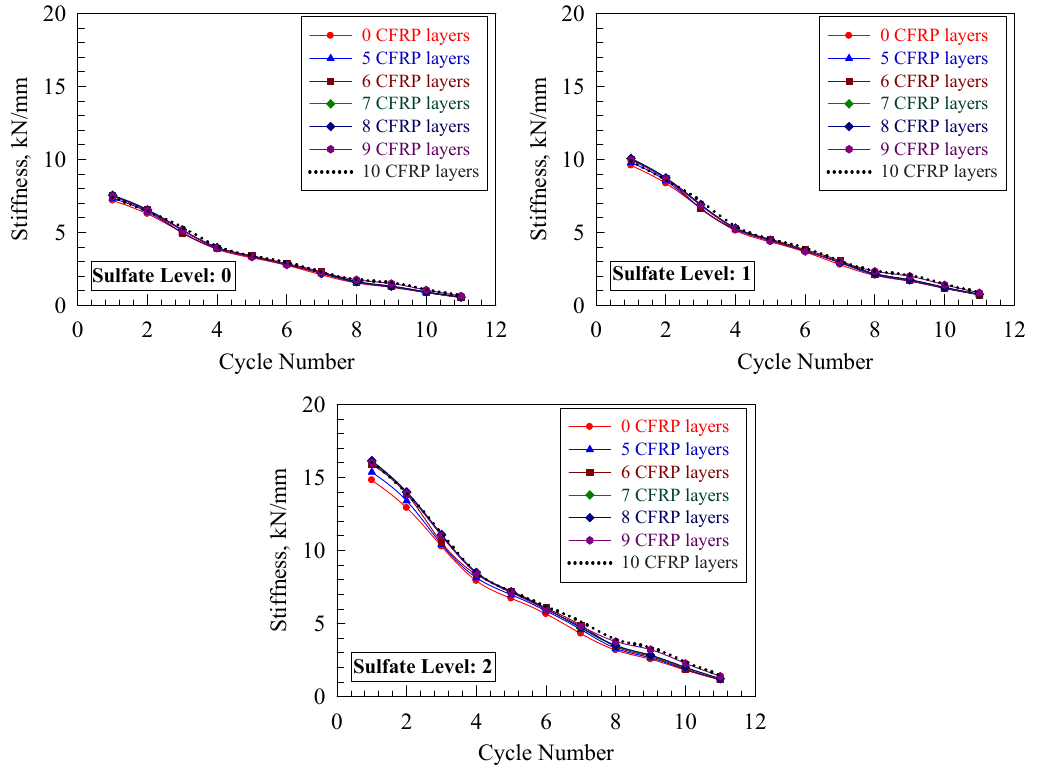
Figure 16. Stiffness